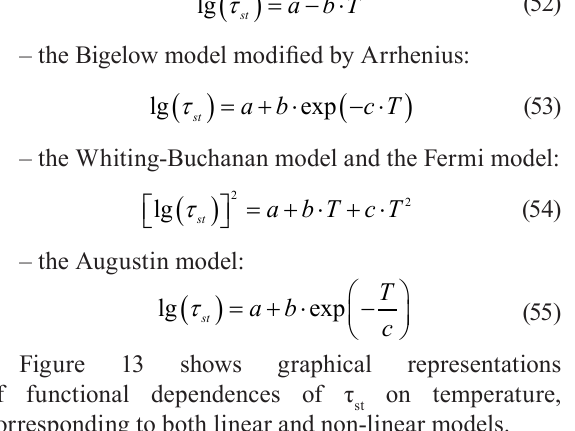
on temperature, st